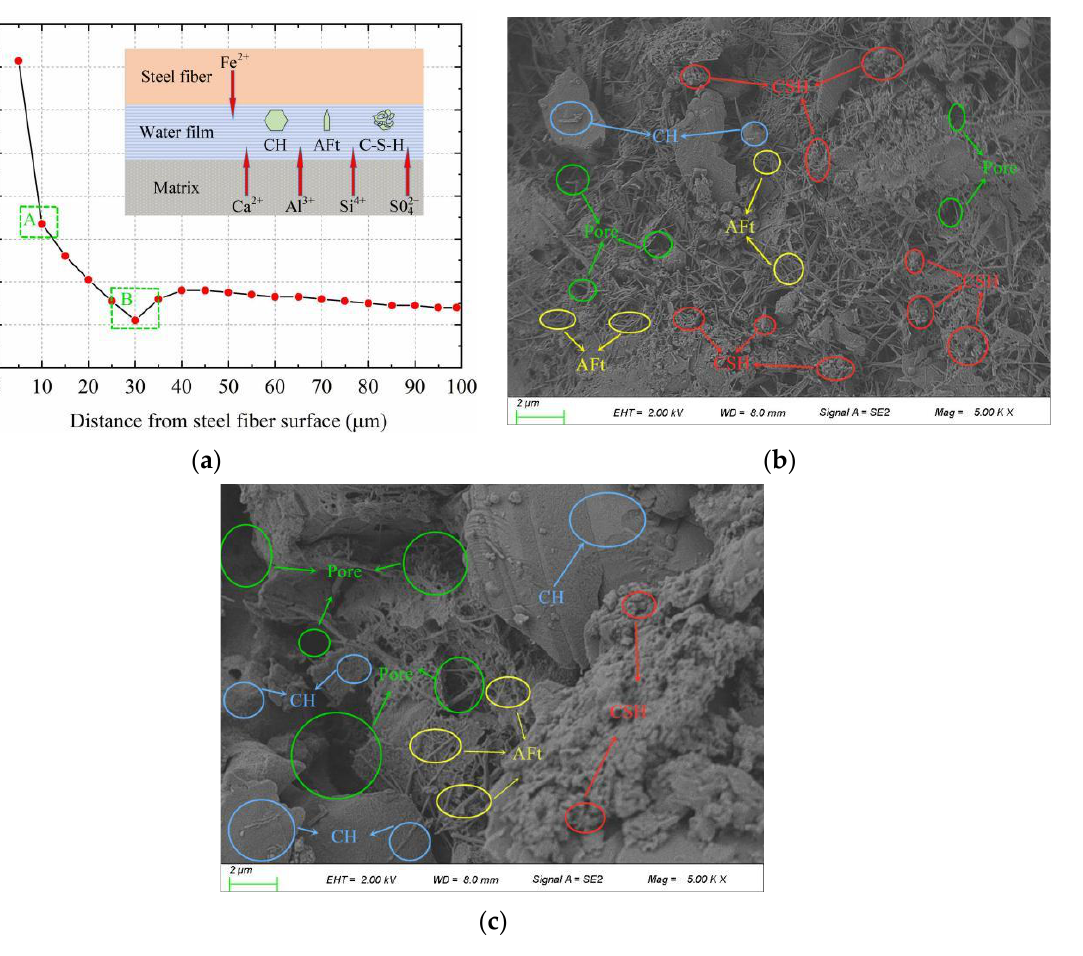
Figure 16. Micromorphology of SFRRC: ( a ) Element fraction by EDXA; ( b ) A area; ( c ) B area.